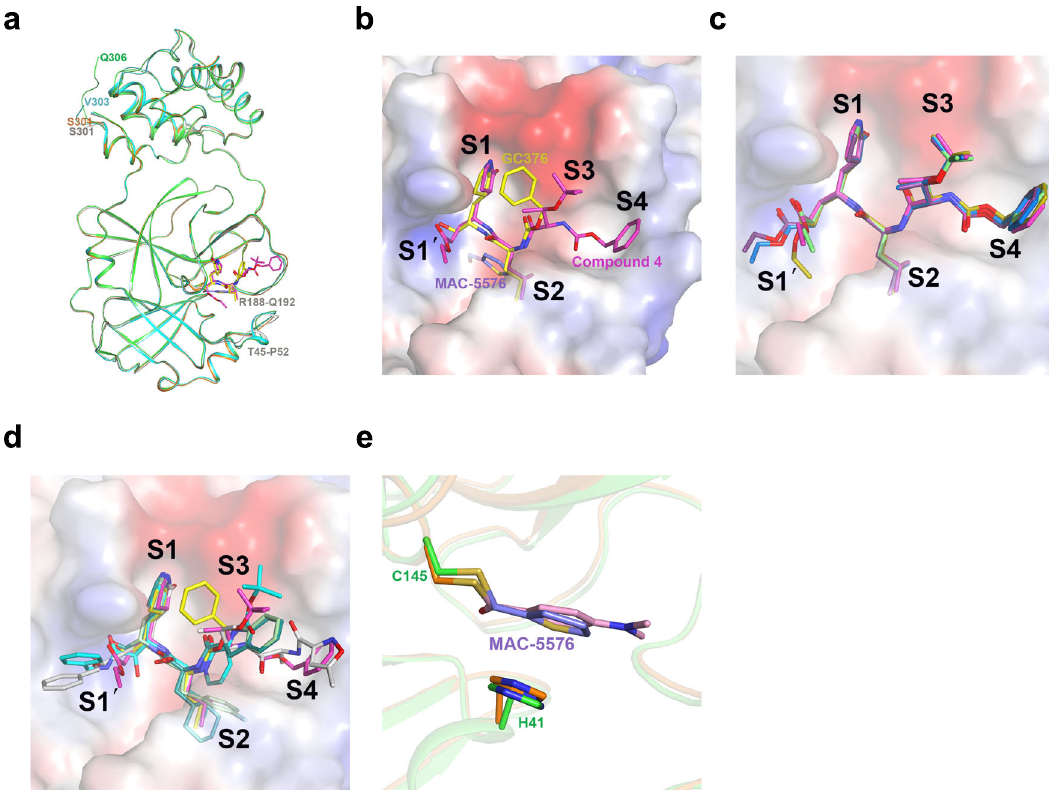
Fig. 4 Overlays of the crystal structures. a Crystal structure of the ligand-free 3CL pro (gray), in complex with, compound 4 (green for 3CL pro and magenta for compound 4), GC376 (cyan for 3CL pro and yellow for GC376), and MAC-5576 (orange for 3CL pro and purple for MAC-5576). One protomer for each structure is shown, with the inhibitors shown with stick models. The terminal residue of each structure, as well as two stretches of residues near the binding site that exhibit local conformational change between the ligand-free and inhibitor-bound structures are labeled. b Overlay of all three compounds in the substrate-binding pocket of the 3CL protease. c Overlay of fi ve molecules of compound 4, one from space group C 2 (magenta) and four from four promoters in space P 1 (light green, purple, marine, dark gold) for compound 4 bound to promoter A, B, C, and D of space group P 1, respectively. d Comparison of the binding modes of compound 4 and GC376 with other peptide-like inhibitors. Compound 4 (magenta) and GC376 (yellow) were overlaid with previously identi fi ed compounds, compound 13b (cyan, PDB: 6Y2F), compound 11a (dark green, PDB: 6LZE), compound 11b (light green, PDB: 6M0K), and N3 (white; PDB: 7BQY). e Comparison of the binding modes of MAC-5576 with XP-59. MAC-5576 (purple) bound to the SARS-CoV-2 3CL protease (orange) was overlaid with XP-59 (pink) bound to the SARS-CoV 3CL protease (green, PDB: